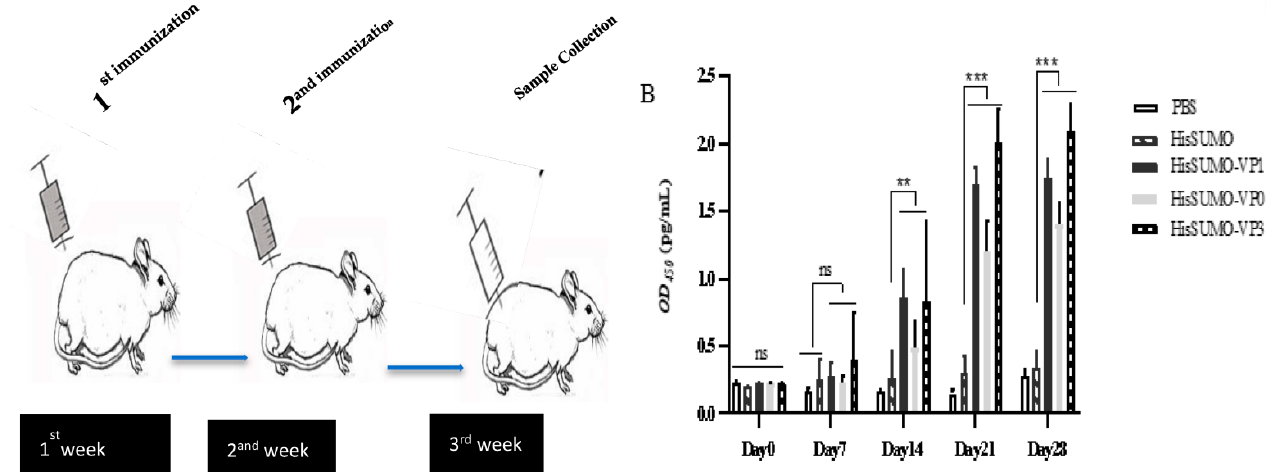
Figure 4. The schematic diagram shows the overall experimental design and schedule, while the graph indicates the ELISA results on the antibody responses of different experimental groups in this study. The ELISA 96-well plates were coated with FMDV-SAT2 purified VLPS and the result shown in the graph is the mean and SD of triplicate samples. The star “*”mark in the graphs denotes the presence of significant difference in each group compared to control groups ( p < 0.05). Furthermore, the number of stars show the degree where the scientific data support significant difference among the groups, as denoted in the following: ns (no star); ** p < 0.01; *** p ≤ 0.001. Generally, the graph shows that the mean antibody titer in mice intramuscularly injected with pET-32a-HisSumo-VP1/pET-32a-HisSumo-VP0/pET-32a-HisSumo-VP3 was significantly higher ( p < 0.01, and p ≤ 0.001) than that in mice injected only with PBS and pET-32a-HisSumo. ( A ) Week one and week two were the vaccination period, and blood was collected during and after vaccination. Blood collection continued on the third week and fourth week. Finally, the mice were euthanized on the fourth week. ( B ) According to the ELISA results, the titer of the anti-FMDV-VLPS antibody in mice serum before immunization and during first injection had no significant difference ( p > 0.05) in all groups. After the booster dose, the antisera titer in the treatment groups was significantly higher than the titers in the serum of the negative control mice p < 0.01. The antibody response was exponentially elevated during the third and fourth weeks in groups C, D, and E and showed higher significant variation over the mock and negative control groups p ≤ 0.001.